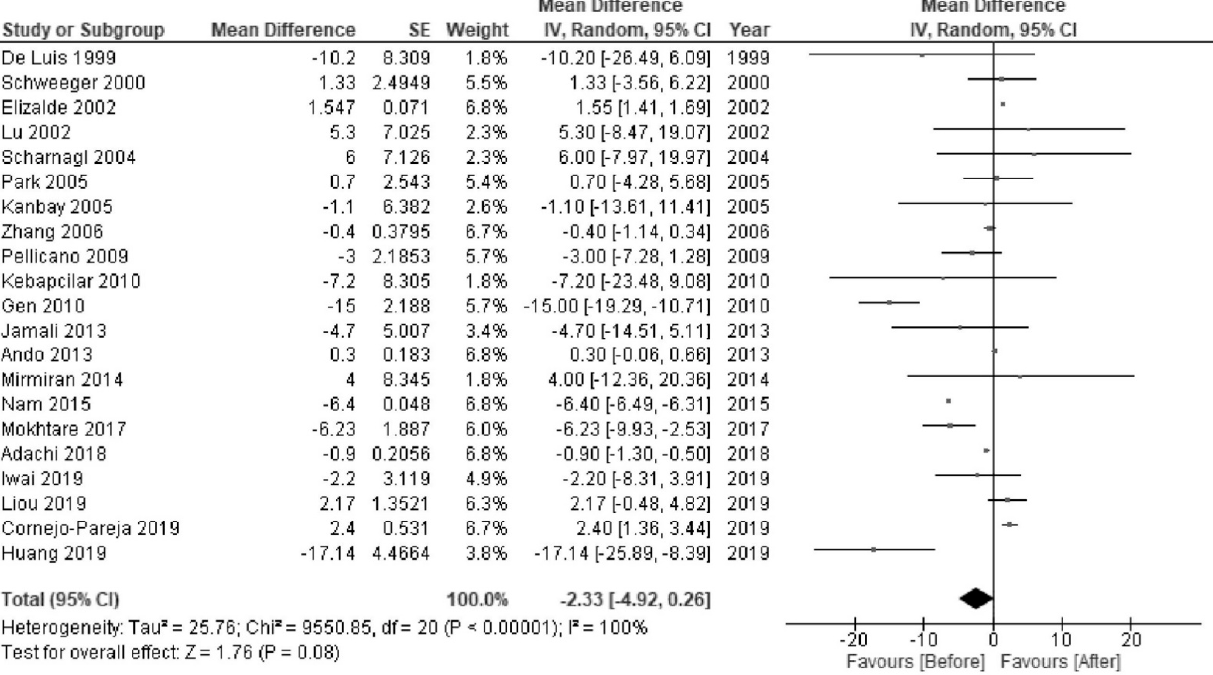
Figure 4. Forest plot of the mean changes in low-density lipoprotein cholesterol levels before and after Helicobacter pylori eradication.